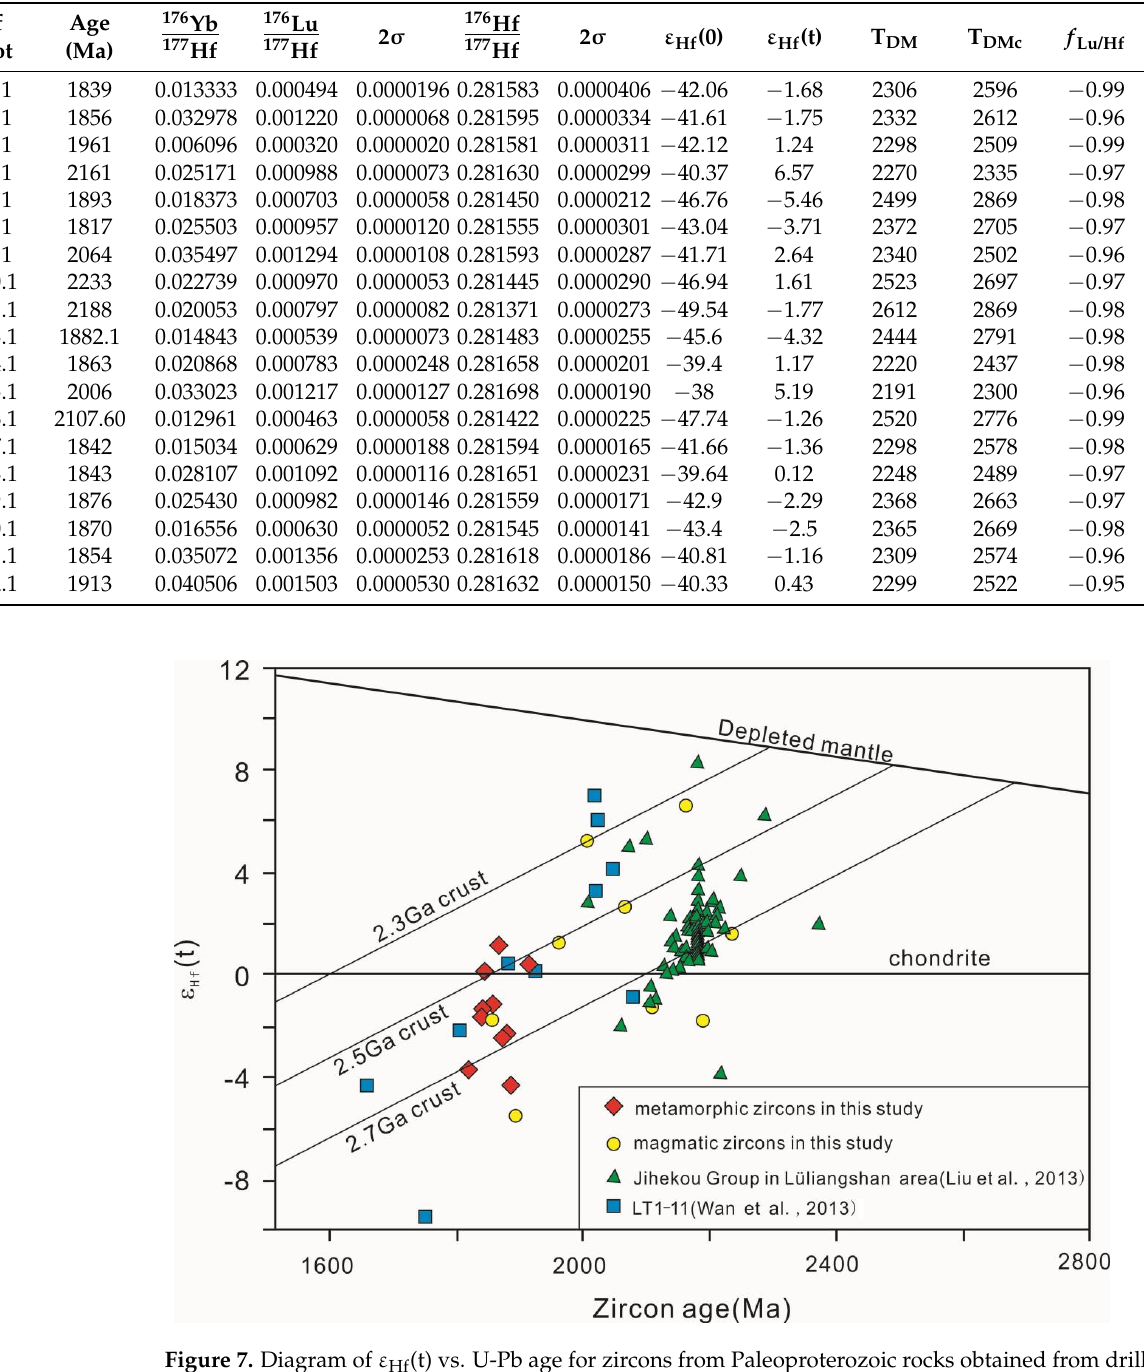
Table 2. Zircon Lu-Hf isotopic data of zircons for granitic gneiss sample ZJ1-3 from drill cores ZJ-1 at northeastern Ordos Basin.